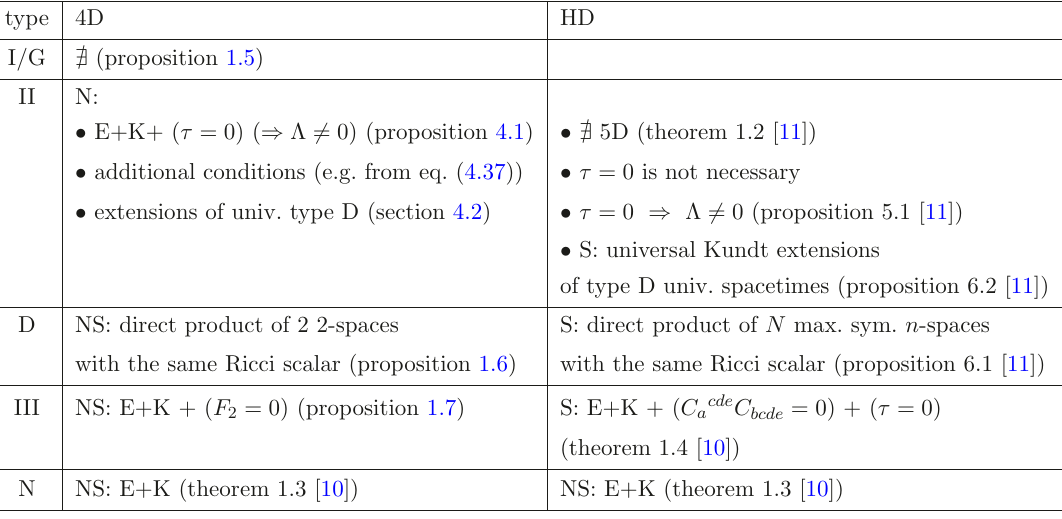
Table 1 . Universal spacetimes in four and higher dimensions (HD), known necessary (N)/sufficient (S) conditions for various algebraic types. All universal spacetimes are Einstein (E) and CSI (the- orem 1.2 [10]) and in four dimensions, they are all necessarily Kundt (K) (proposition 1.5). Open